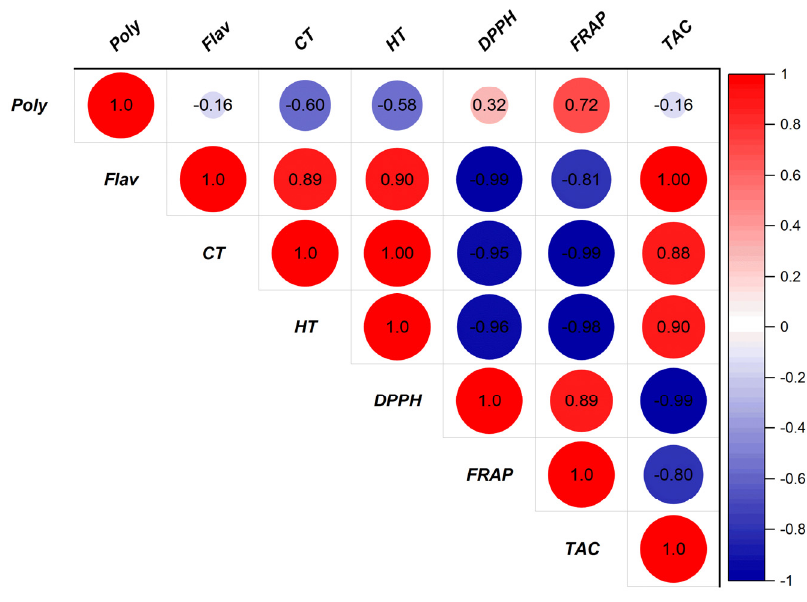
Figure 7. Correlation between antioxidant activities and phenolic compound contents of C. sativus stigma extracts. (Poly: polyphenols; Flav: flavonoids; CT: condensed tannins; HT: hydrolyzable tannins).